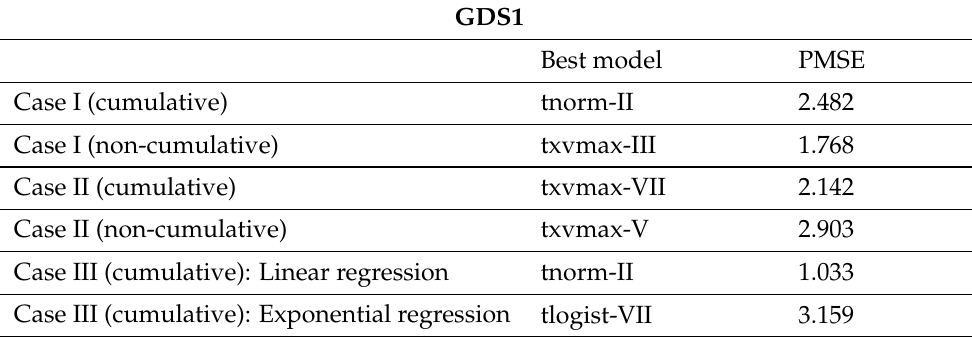
Figure 4. Behavior of the predicted cumulative number of software faults with PI-SRMs and common NHPP-based SRM in GDS1 (80% observation point). Table 6. Predictive performance based on PMSE at 80% observation